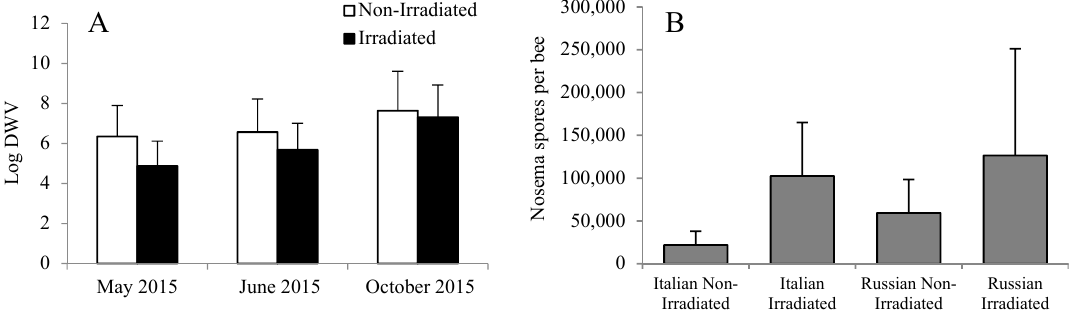
Figure 6. ( A ) Viral load and ( B ) Nosema spore count in Russian and Italian honey bee colonies containing irradiated or non-irradiated combs. For DWV, there was an overall significant reduction in viral load due to the irradiation treatment, with viral load increasing in general through time. DWV: Deformed wing virus.